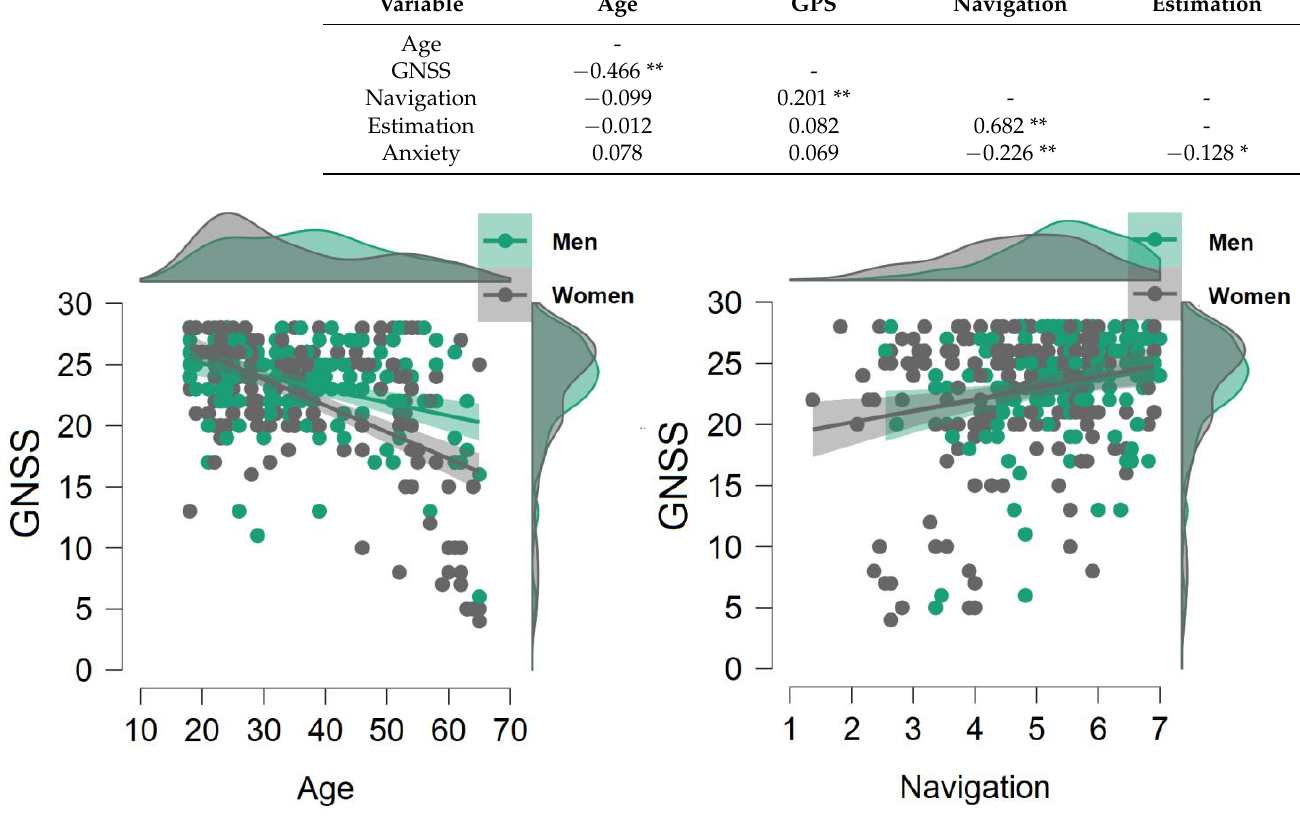
Figure 2. Spearman ’ s Partial Correlations for Age, Navigation, and GNSS, conditioned by gender. Although the assumption of normality was not met for the different variables under study, the shape of the distribution was checked in terms of skewness and kurtosis. In this way, structural equation modeling was performed as well as PLS analysis. The proposed model was examined under structural equation modeling by employing the maximum likelihood method. An acceptable goodness of fit was found, as described in Figure 3.